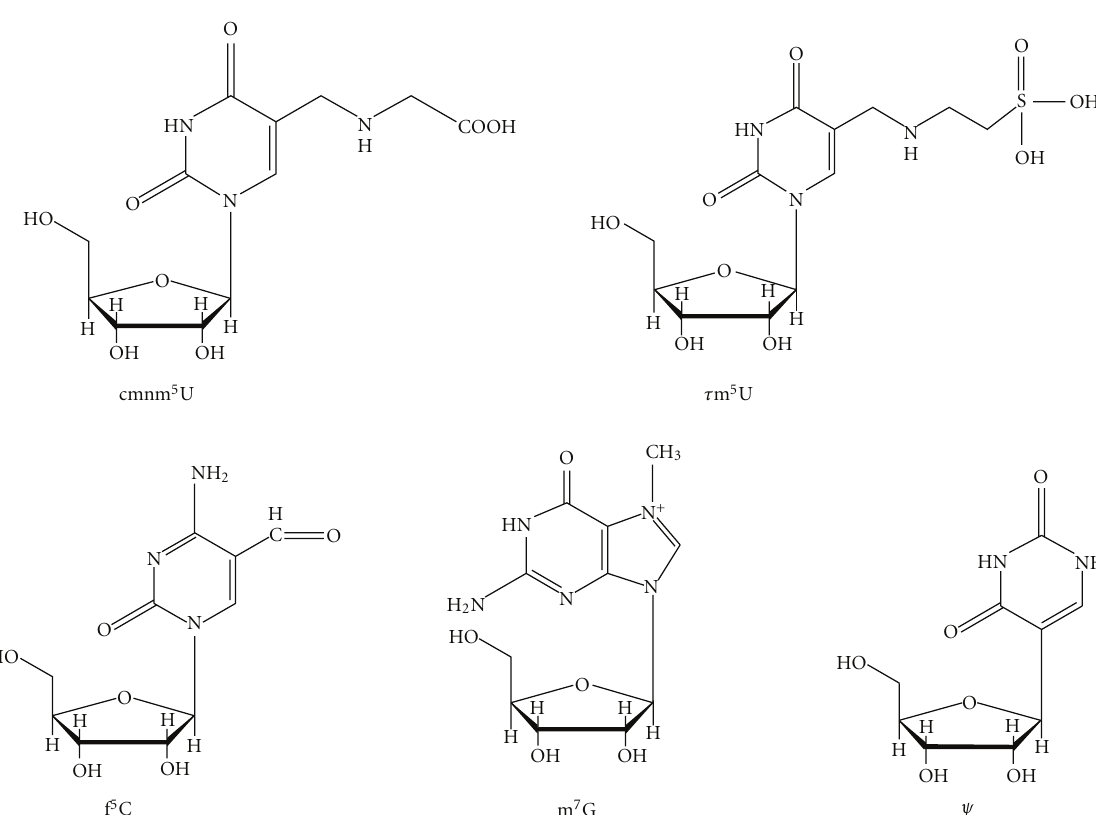
Figure 2: Chemical structures of modified nucleosides located at the anticodon wobble position (cmnm 5 U, τ m 5 U, f 5 C, and m 7 G) and the second position ( Ψ ) of mt